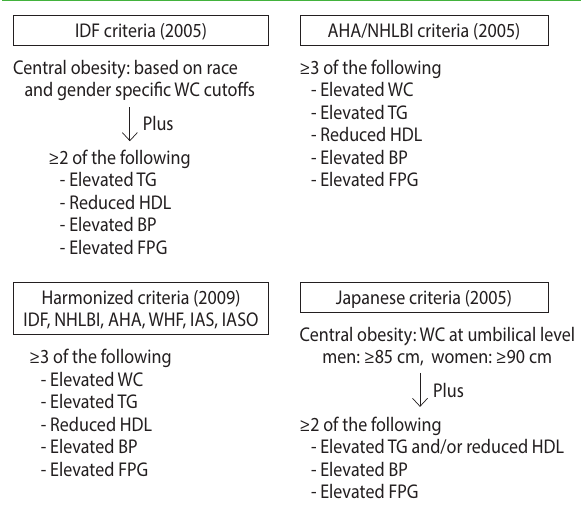
Figure 1. Selected criteria of metabolic syndrome. IDF, International Diabetes Federation; WC, waist circumference; TG, triglyceride; HDL, high-density lipoprotein cholesterol; BP, blood pressure; FPG, fast- ing plasma glucose; AHA, American Heart Association; NHLBI, Na- tional Heart Lung and Blood Institute; WHF, World Heart Federation; IAS, International Atherosclerosis Society; IASO, International Asso- ciation for the Study of Obesity; BMI, body mass index; SBP, systolic blood pressure; DBP, diastolic blood